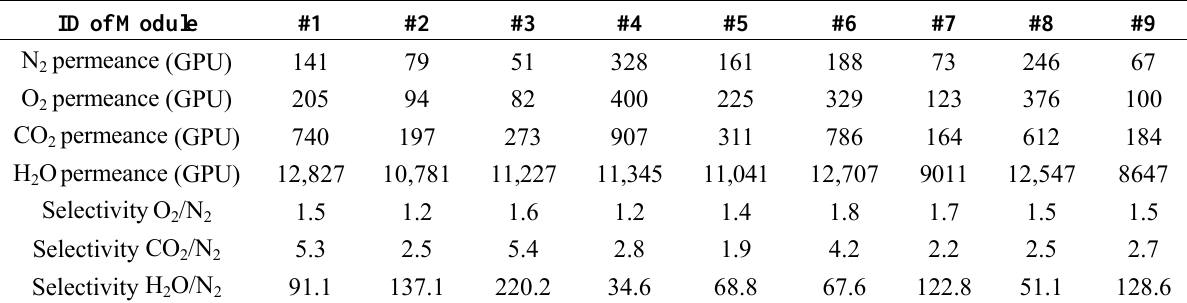
PAN/PDMS hollow fiber